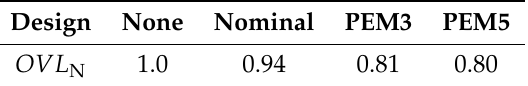
Table 4. Results for the overlap.